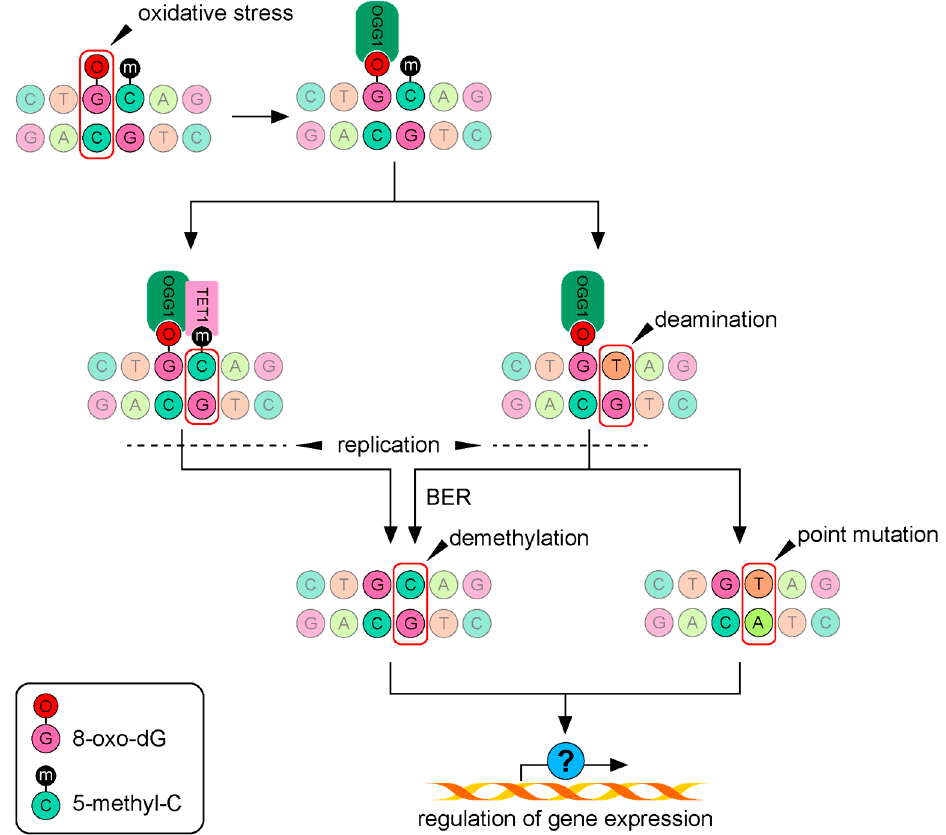
Figure 2. Oxidative stress can alter gene expression regulation by inducing both point mutations and epigenetic changes. Oxidized guanosine is recognized by 8-oxoguanine glycosylase (OGG1), a DNA base repair enzyme involved in base excision repair (BER). It can either recruit TET1 to bind and demethylate neighboring methylated cytosine (5-mC) or induce point mutations by initiating the deamination of 5-mC to thymine. During DNA replication, the thymine can be recognized and replaced with cytosine (BER), which removes DNA methylation. Alternatively, the point mutation is propagated by DNA replication, with unpredictable effects on gene expression.